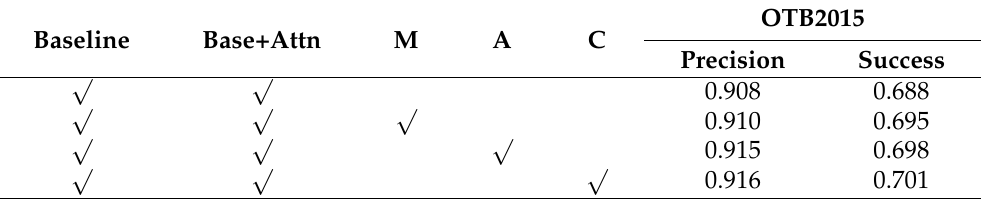
Table 6. Ablation experiments on dataset OTB2015-2 (Baseline for SiamRPN++ network architecture, Base+Attn: multi-domain attention mechanism applied on two branches of the feature extraction network, M: compensation combination in the form of the dot product, A: weighted, C: connected, the right-hand metric for